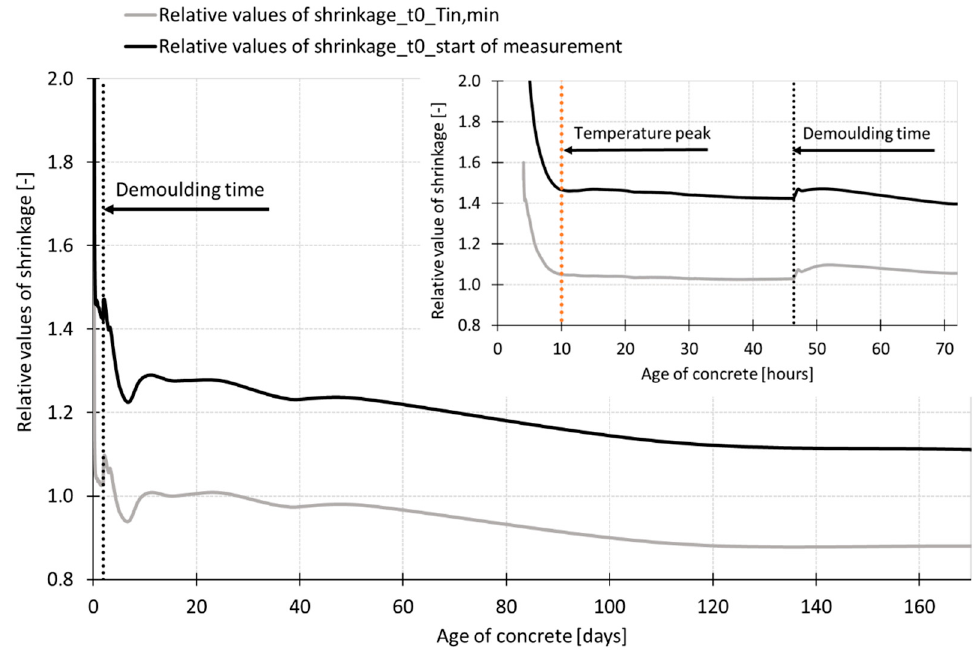
Figure 15. E ff ect of specimens’ size: Relative values of shrinkage at di ff erent time t 0 Figure 15. Effect of specimens’ size: Relative values of shrinkage at different time t 0 .